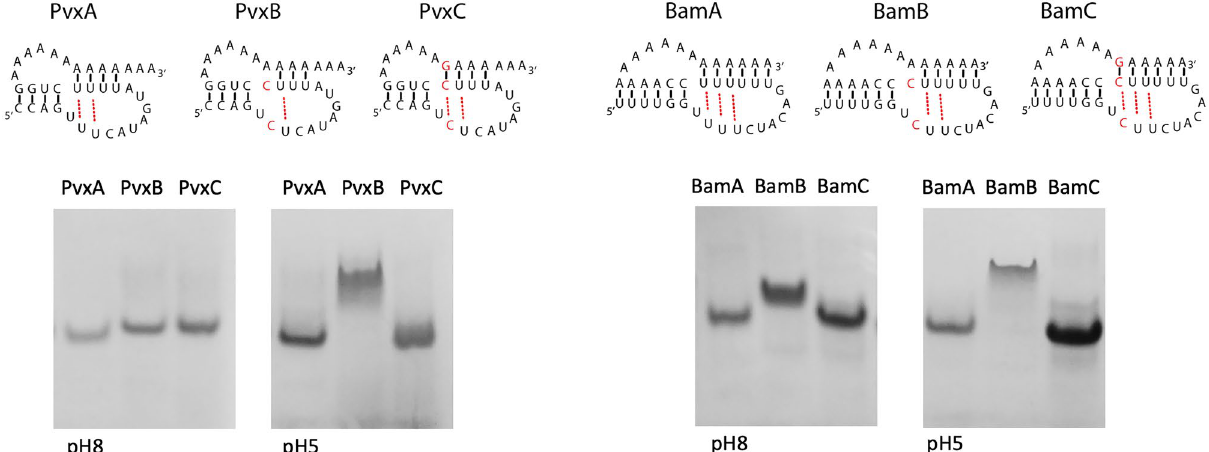
Figure 7. Native gel electrophoresis at pH 8 and 5 of PVX and BaMV pseudoknot RNAs. RNAs were visualized by Stains-All.